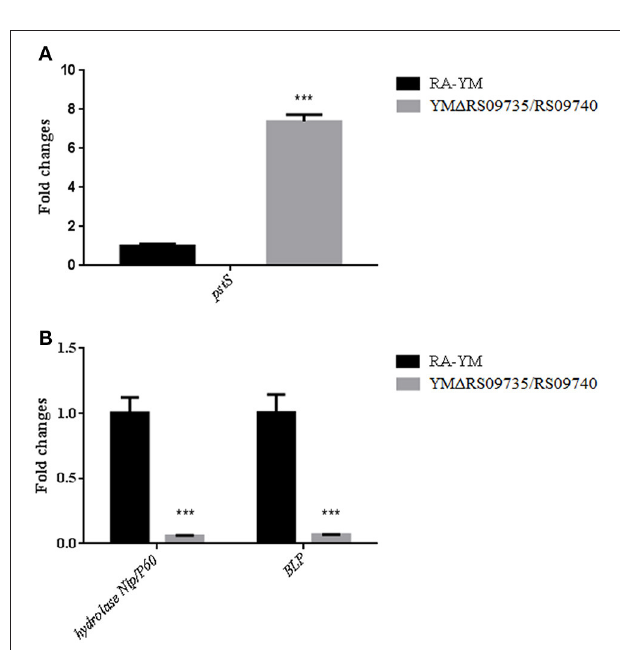
FIGURE 8 | Real-time PCR verification of three predicted virulence-associated genes expression in YM 1 RS09735/RS09740 mutant strain. (A) The fold expression changes of pstS gene in mutant strain. (B) The fold expression changes of two predicted virulent genes hydrolase Nlp/P60 and BLP in mutant strain. *** P <